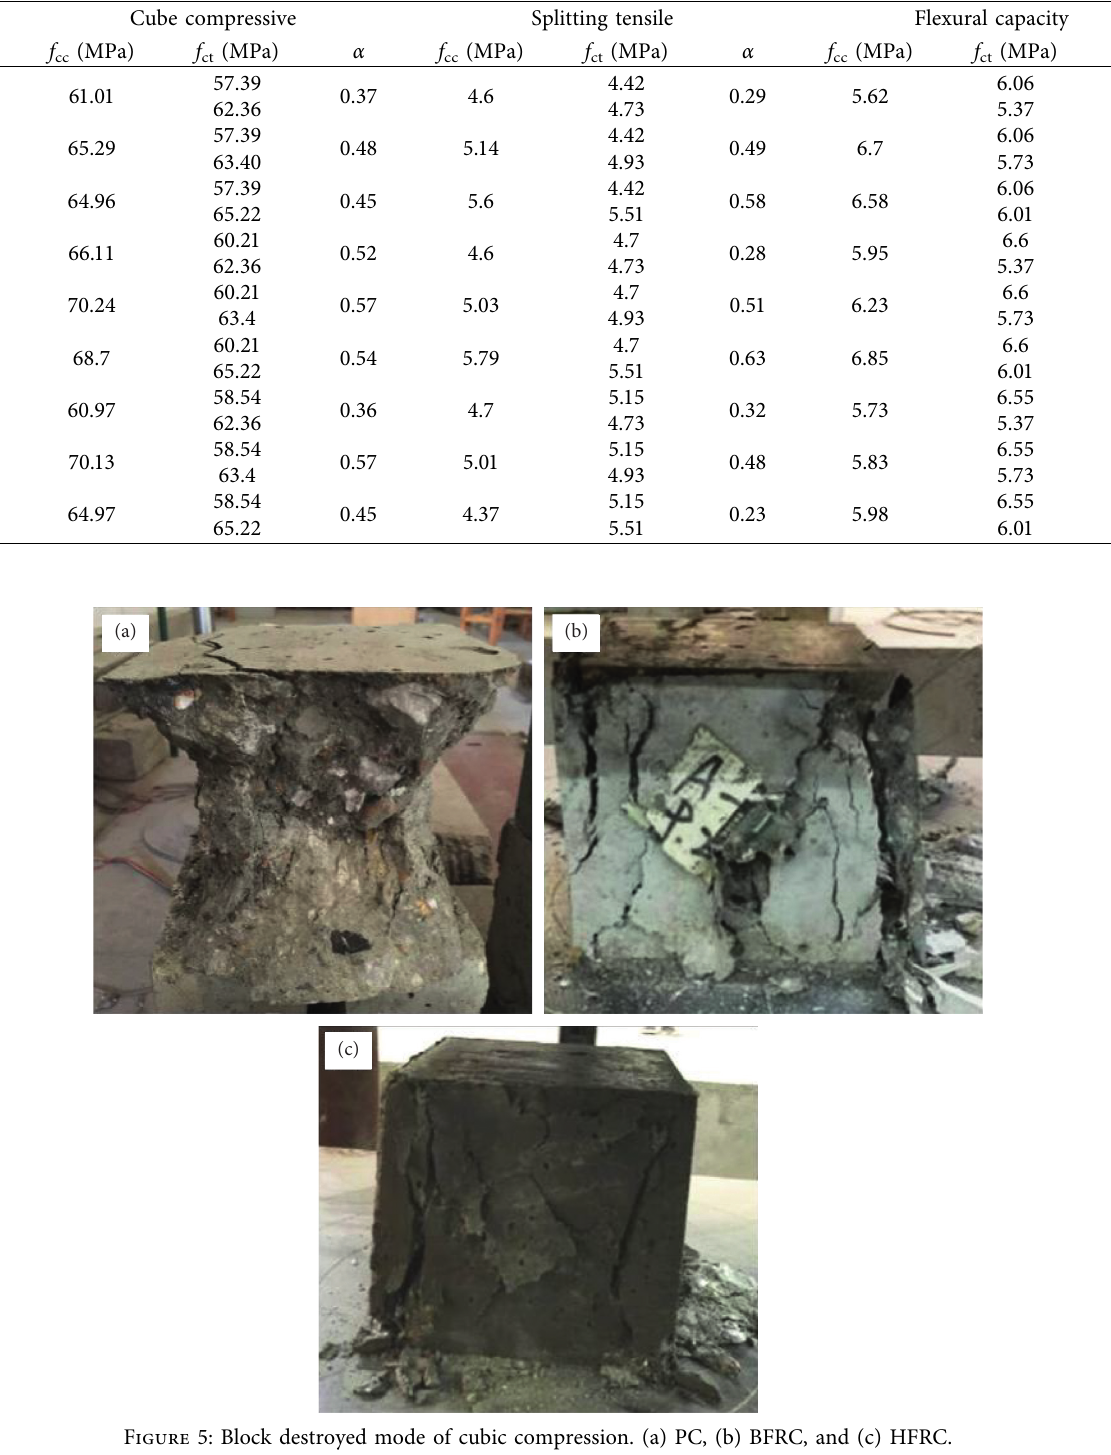
Table 4: Calculation results of fiber mixed effect coefficient.